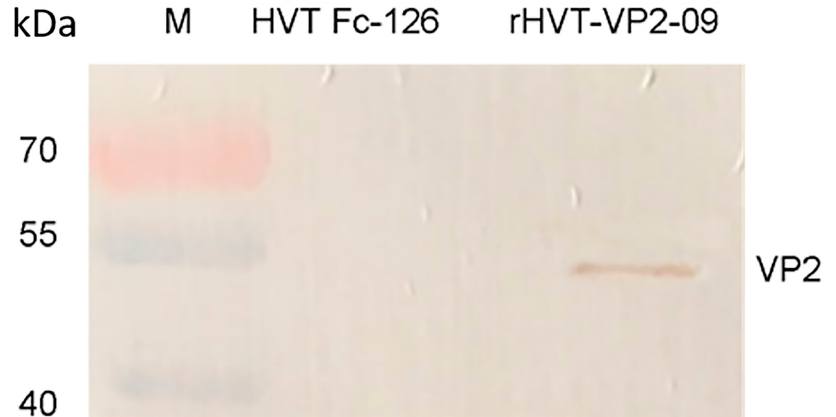
Figure 6. Western-blotting analysis of VP2 expression of HVT-VP2-09. Lysates of CEFs infected with HVT Fc-126 and HVT-VP2-09. Proteins were separated by SDS-10% polyacrylamide gel elec-